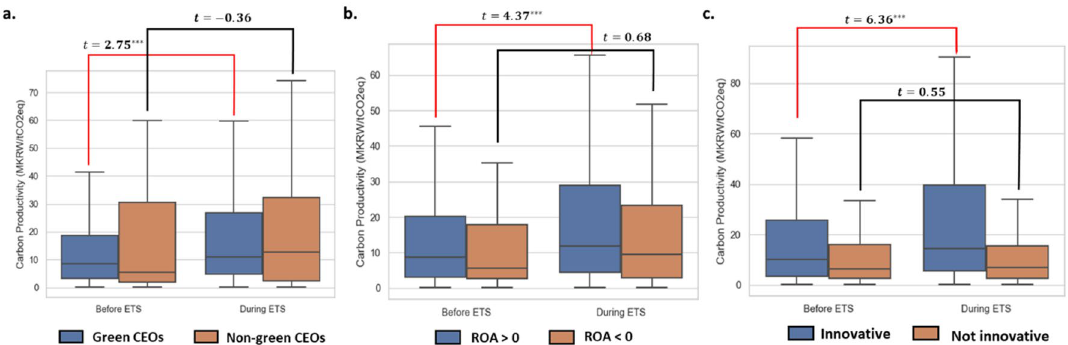
Figure 4. Mechanisms for increasing carbon productivity before and during ETS. Firms are grouped by ( a ) profitability (return on assets, ROA), ( b ) innovation, and ( c ) board characteristics. T-statistics compare carbon productivity values with statistical significance marked as *** for a p-value < 0.01, ** for a p-value < 0.05, and * for a p-value < 0.1.